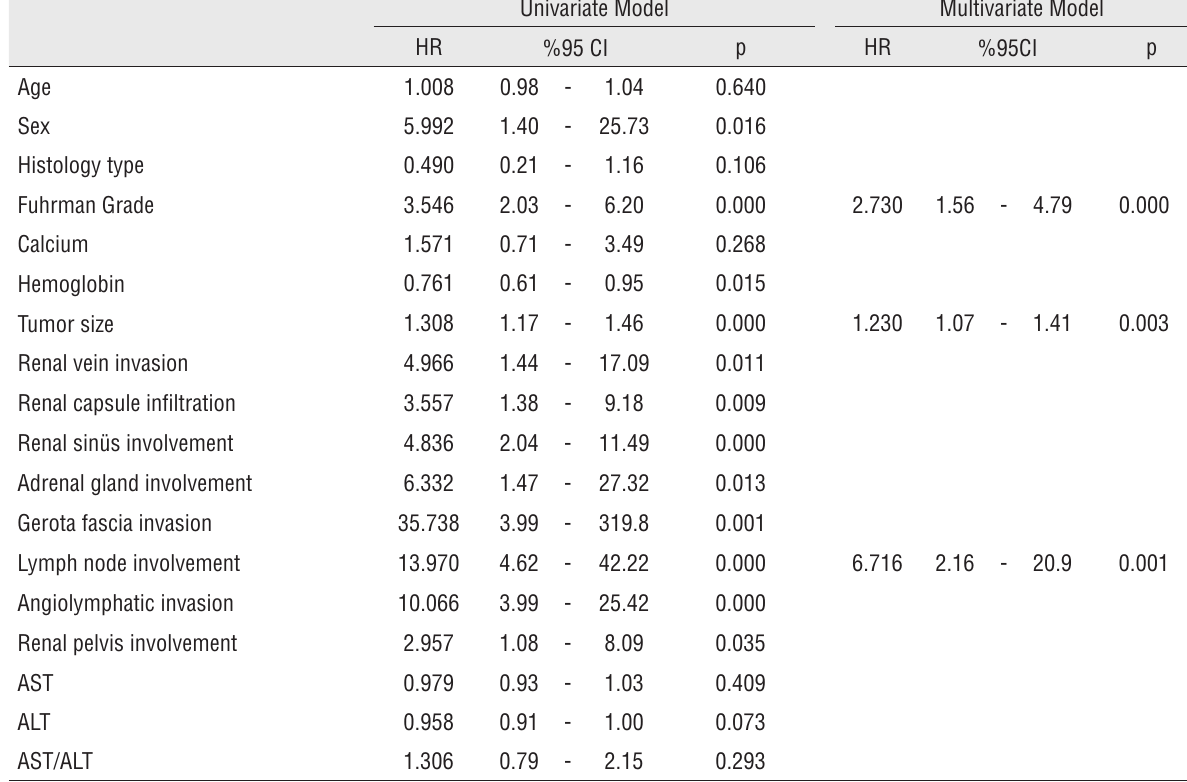
Table 2 - Univariate and multivariate Cox regression models of clinicopathological characteristics for the prediction of cancer specific